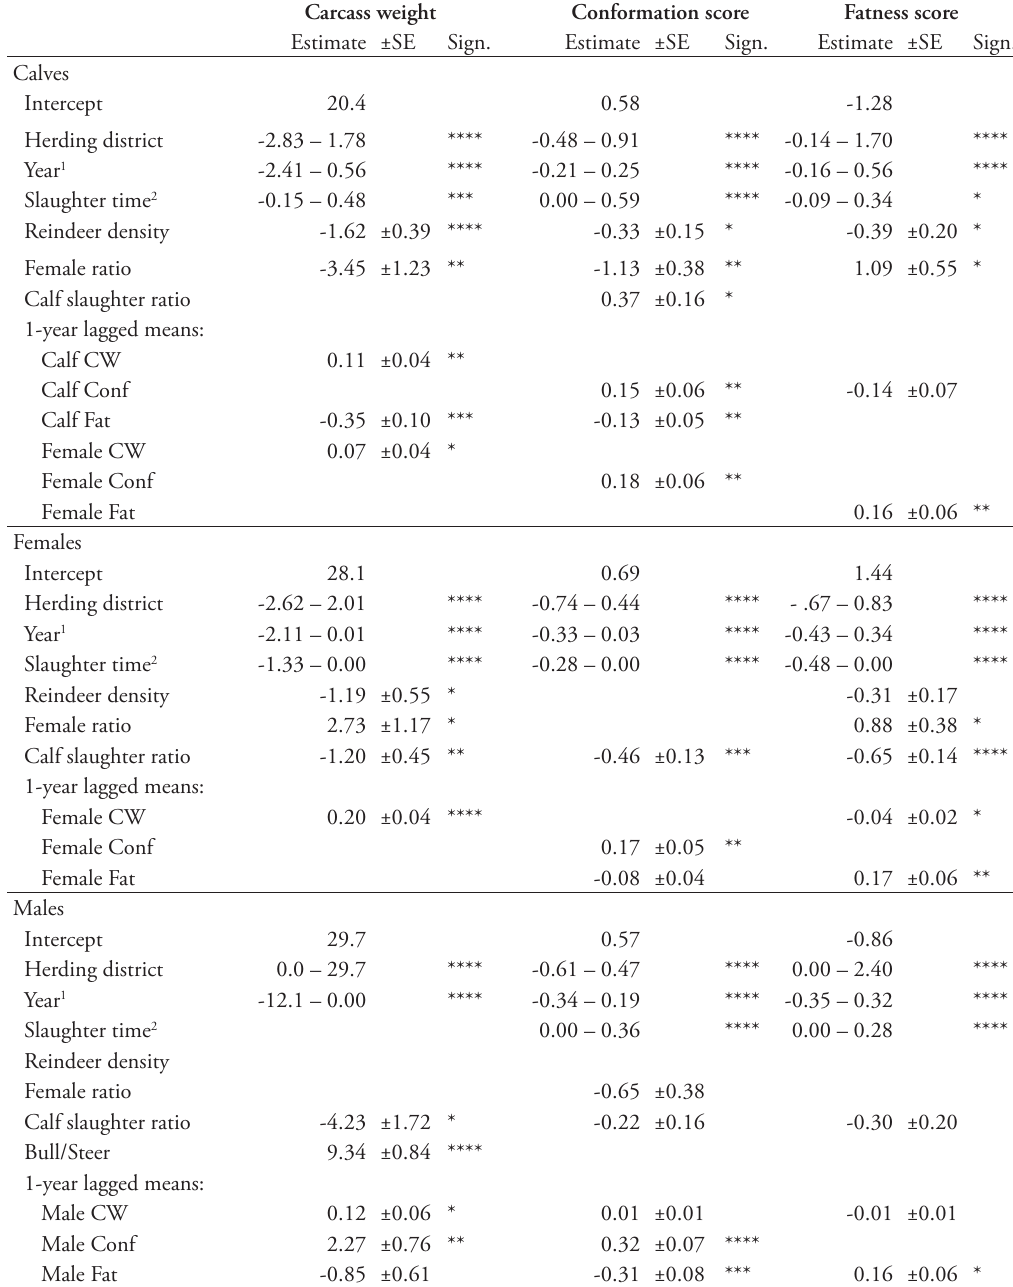
Table 2. Estimated effects (ranges for class variables), standard errors (SE) and significances of the